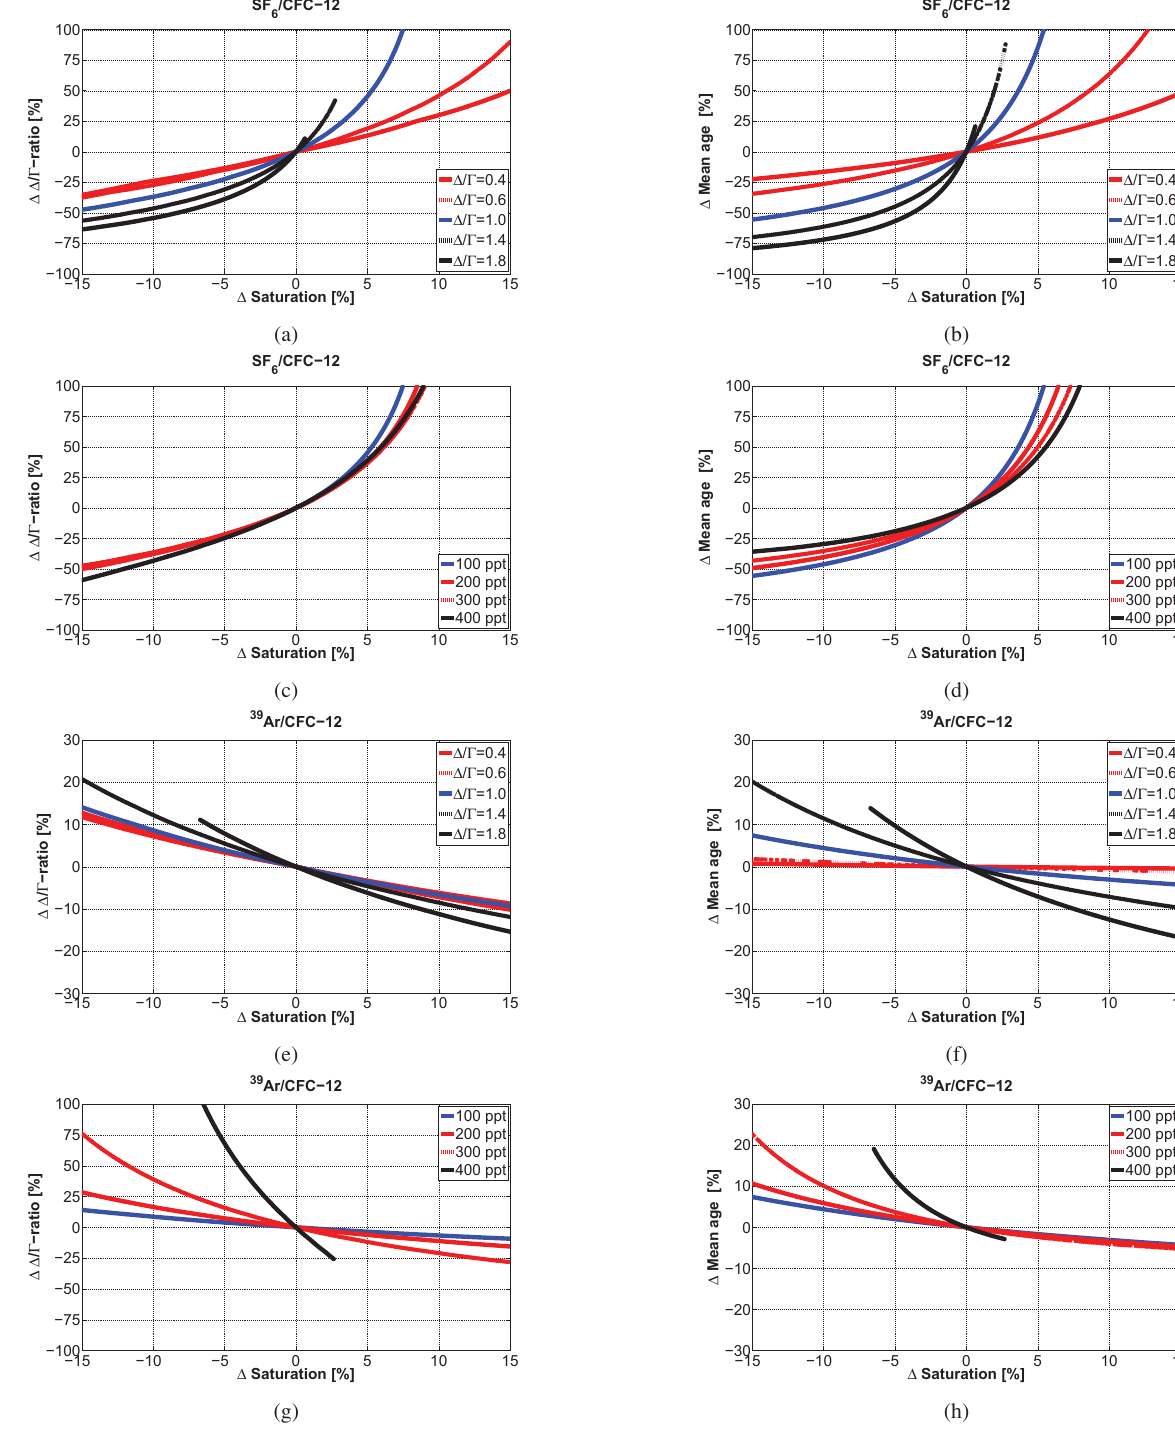
Fig. 5: Δ / Γ ratio and mean age sensitivities to deviations in CFC-12 saturation based on the combination with ( a - d ) SF 6 and ( e - h ) 39 Ar. The sensitivities are shown for either a constant initial CFC-12 concentration of 100 ppt and a changing initial Δ / Γ ratio ( a , b , e and f ) or a changing initial CFC-12 concentration and a constant initial Δ / Γ ratio of 1 . 0 ( c , d , g and h ). The related tracer concentrations of SF 6 and 39 Ar are backcalculated by using the IG-TTD.